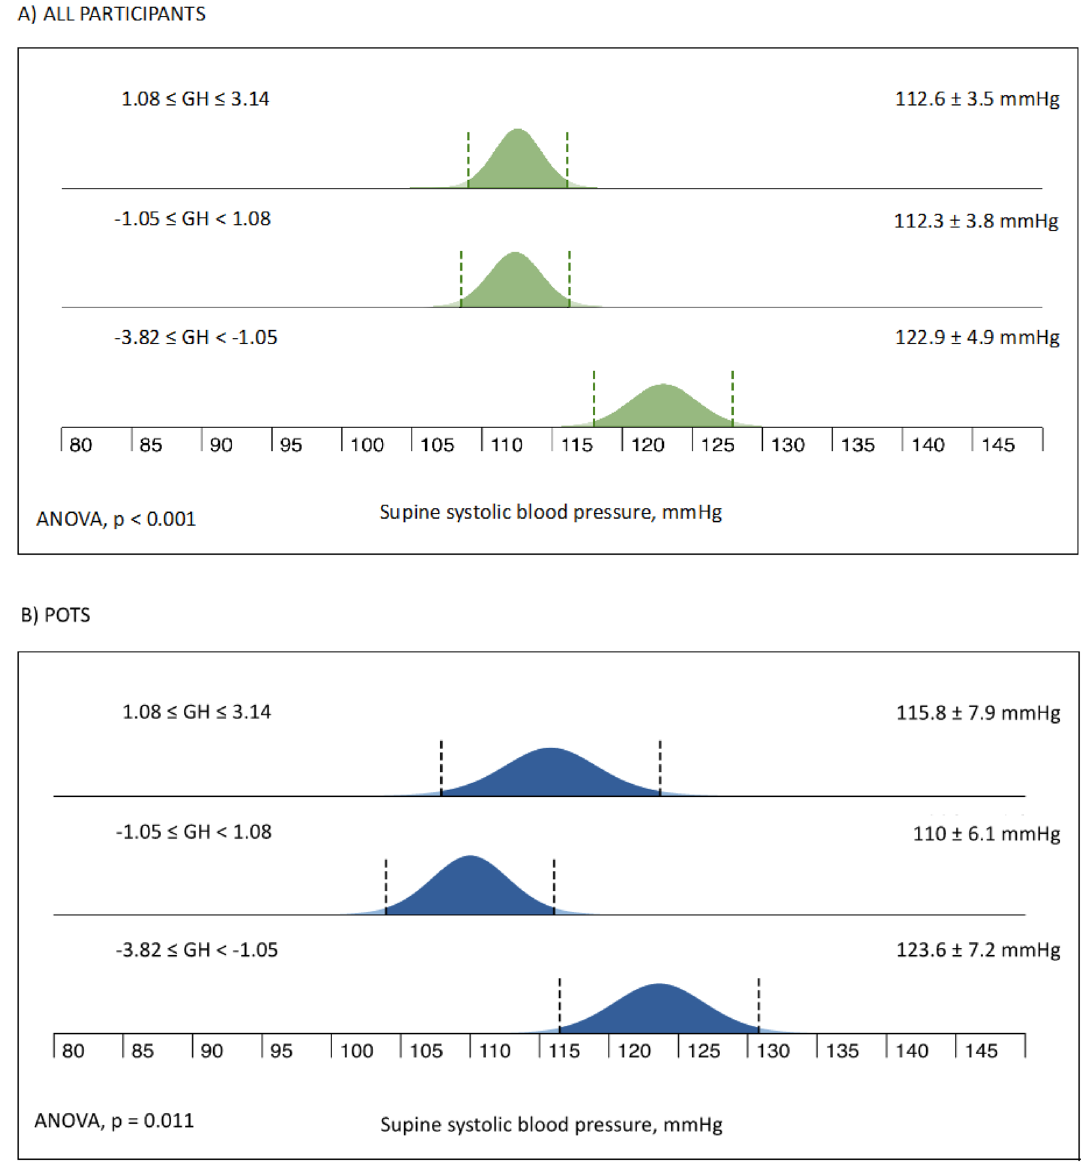
Figure 3. Supine systolic blood pressure by tertiles of circulating growth hormone levels in all participants ( A , n = 84) and in POTS patients ( B , n = 42). GH, growth hormone; POTS, postural orthostatic tachycardia